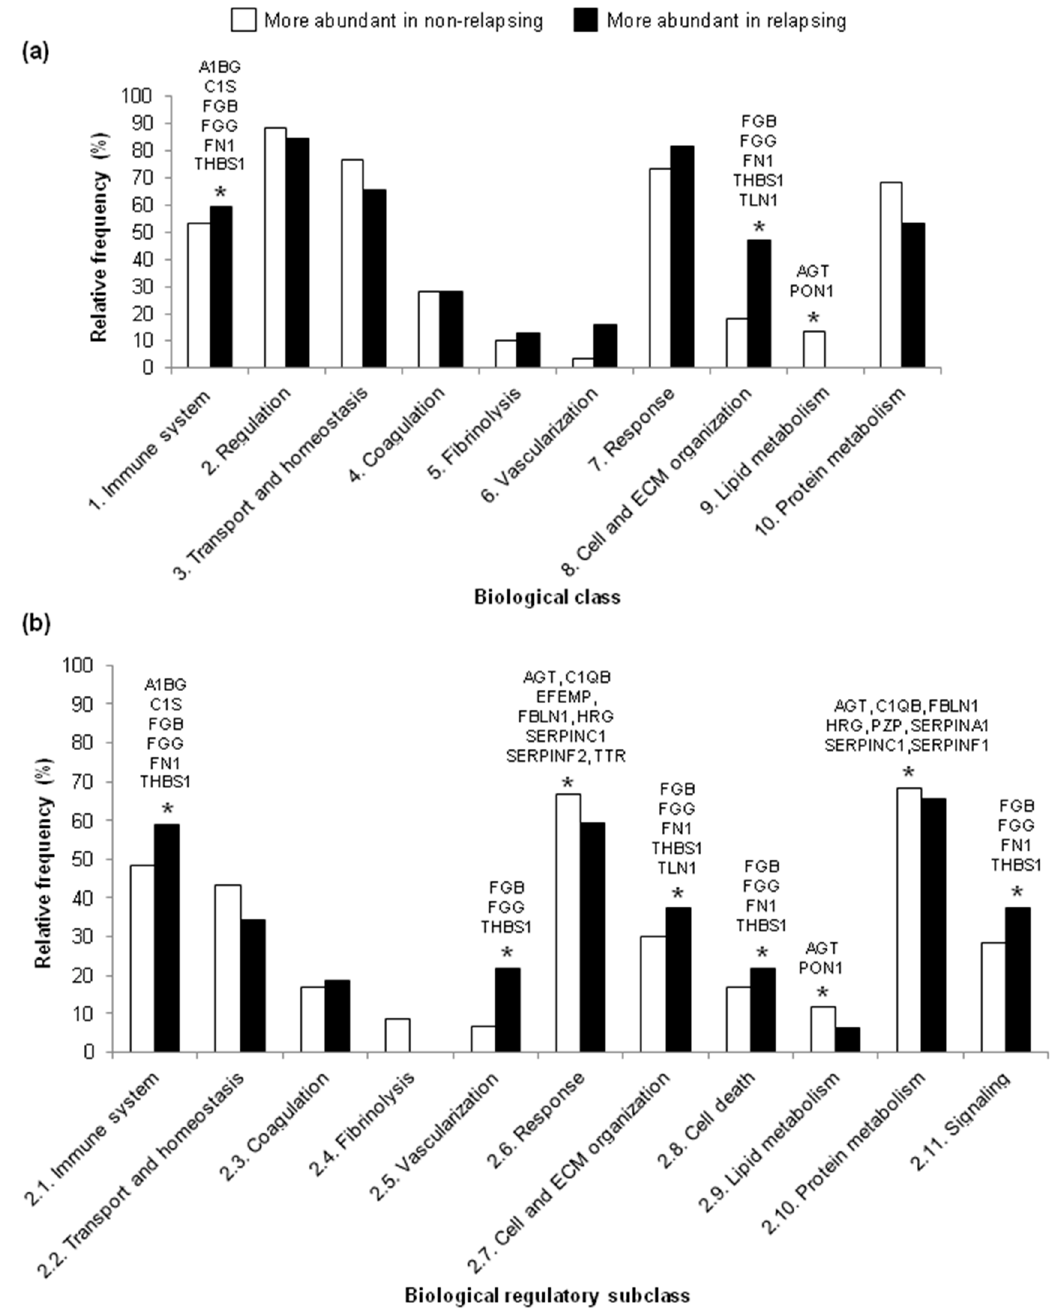
Figure 3. Relative frequencies of the differentially abundant proteins in 10 biological classes ( a ) and 11 biological regulatory subclasses ( b ) in the explorative analysis of pediatric HL patients. Gene symbols above bars marked with an asterisk refer to proteins involved in those processes that were also identified in the validation analysis. Corresponding data for the validation analysis are shown in Figure S1.